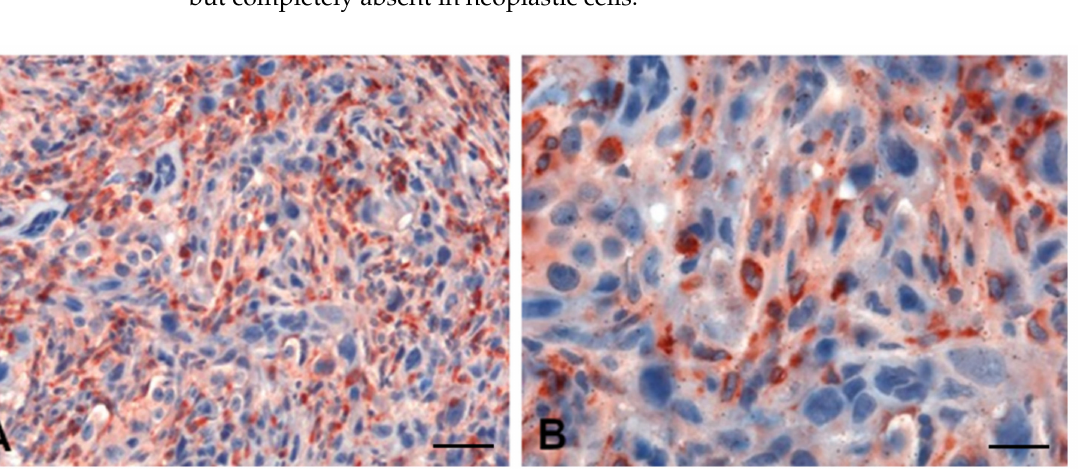
Figure 6. C1q expression within the MPM tumor microenvironment. Immunohistochemical analysis of C1q expression in MPM specimens highlighted massive presence of C1q in the tumor stroma and in the cytoplasm of monocytoid cells. Staining was revealed using a polymer detection kit (Novocastra, Leica Biosystems) and the AEC (3-amino-9-ethylcarbazole, Dako, Denmark) substrate chromogen. Slides were counterstained with Harris Hematoxylin (Novocastra, Leica Biosystems). Magnification: ( A ) 200 × , scale bar, 100 µ m; ( B ) 400 × , scale bar, 50 µ